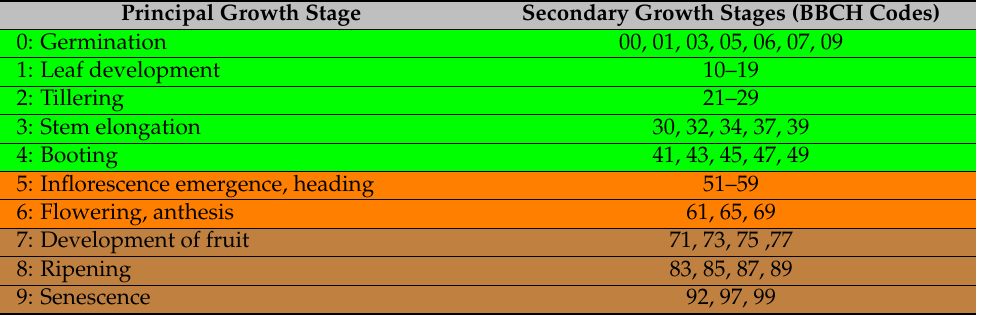
Table 3. BBCH scale used to describe rice phenology. Green: vegetative phase. Orange: reproductive phase. Brown: maturation